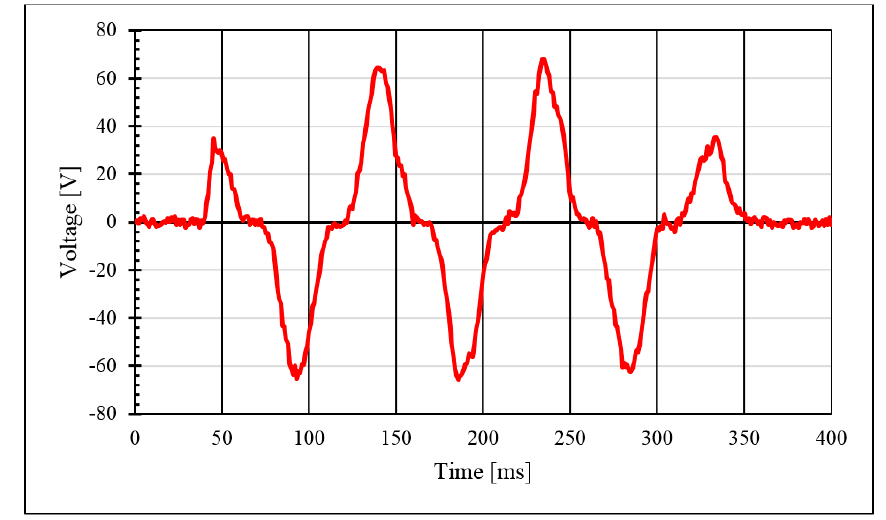
Figure 6. No load emf in the single phase PM generator.